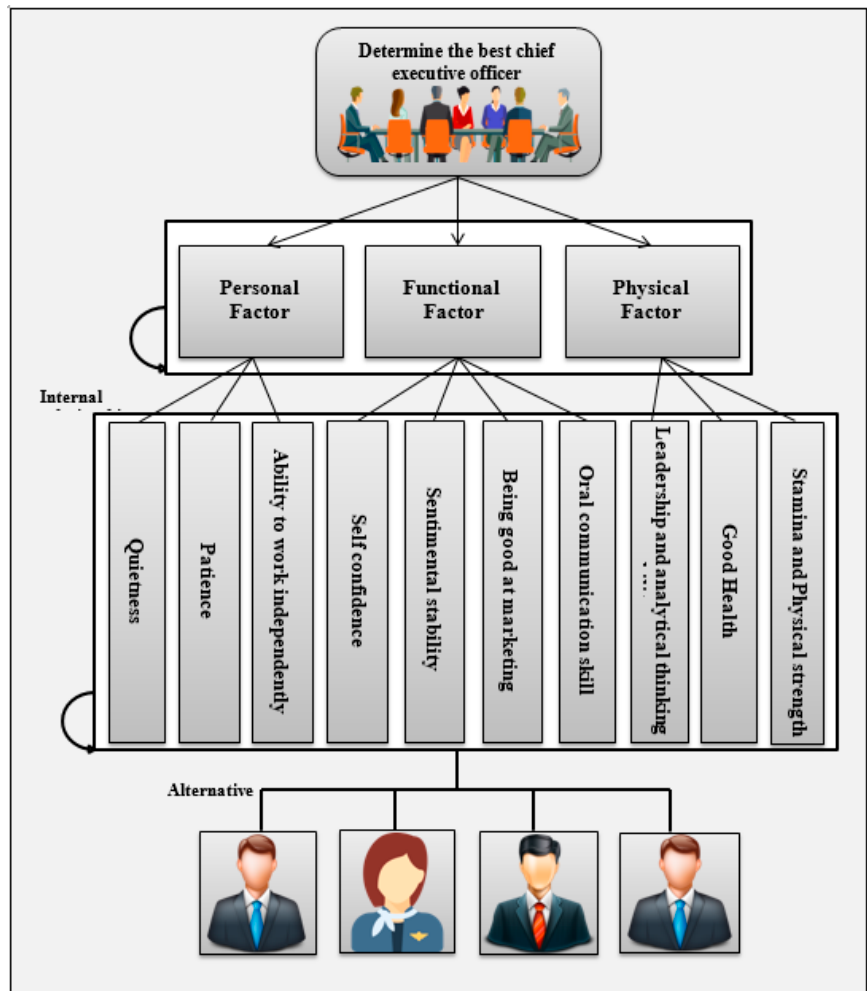
Figure 5. The analytic network process model for selecting CEO. Step 4. Construct the comparison matrices among criteria and calculate weights of the